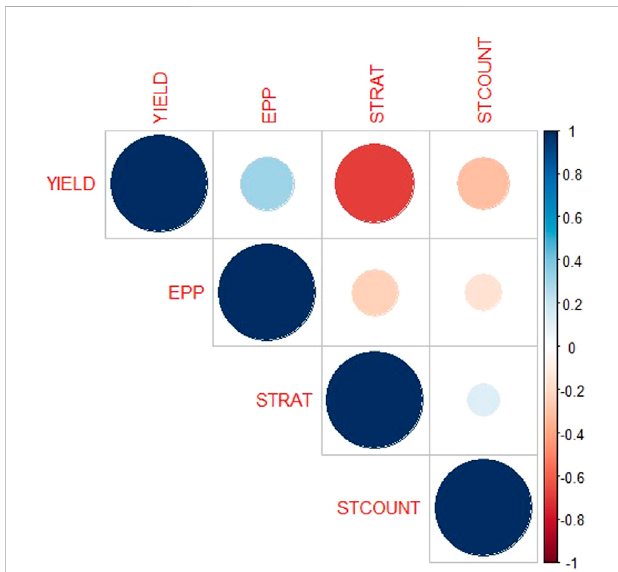
FIGURE 2 Relationship among Striga adaptive traits in the F 2:3 mapping population across four Striga -infested environments. YIELD — Grain yield, EPP — number of ears per plant, STRAT — Striga damage rating, STCOUNT — Striga emergence counts. Gradient bars represent the correlation coef fi